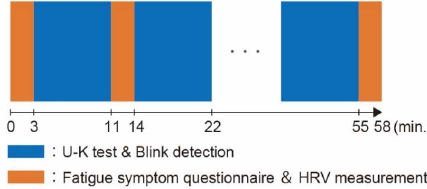
Figure 2. Protocol of the fatigue assessment experiments.